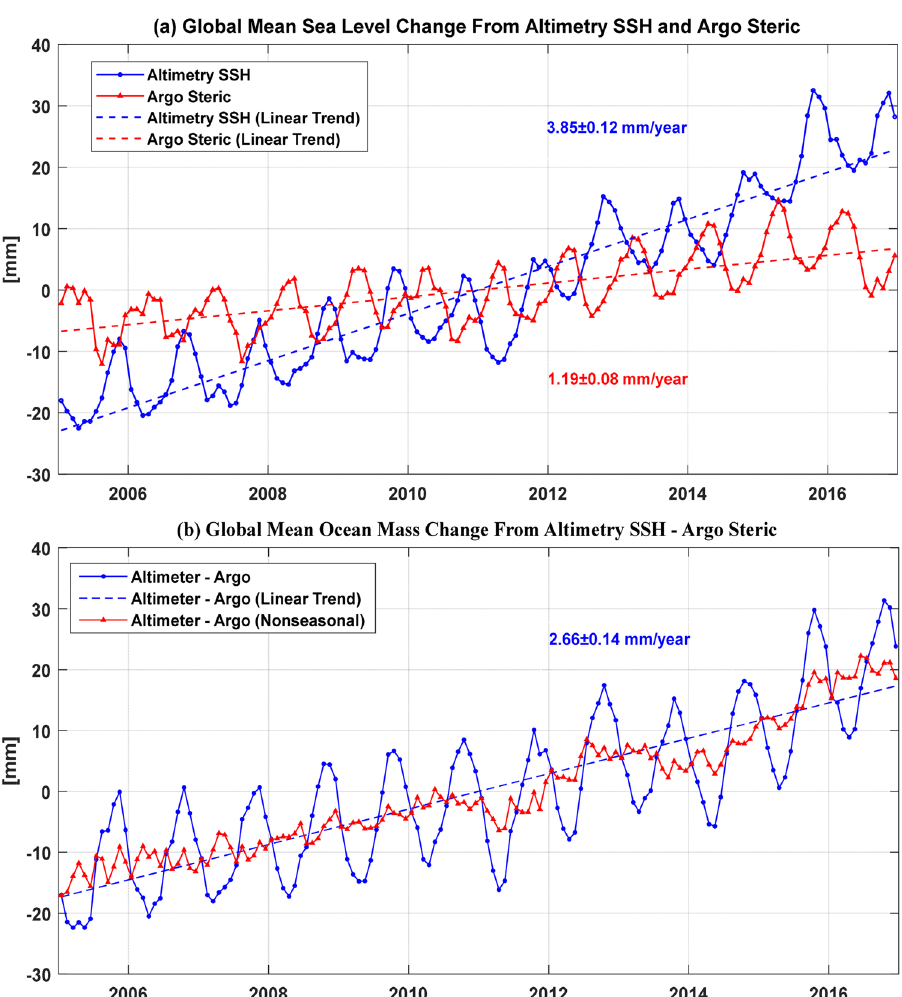
Figure 1. ( a ) GMTSL change derived by satellite altimetry and steric change estimation from the average of three Argo products (IPRC, SIO and CSIO) over the period from January 2005 to December 2016. ( b ) Monthly GMOM change derived from altimetry minus Argo